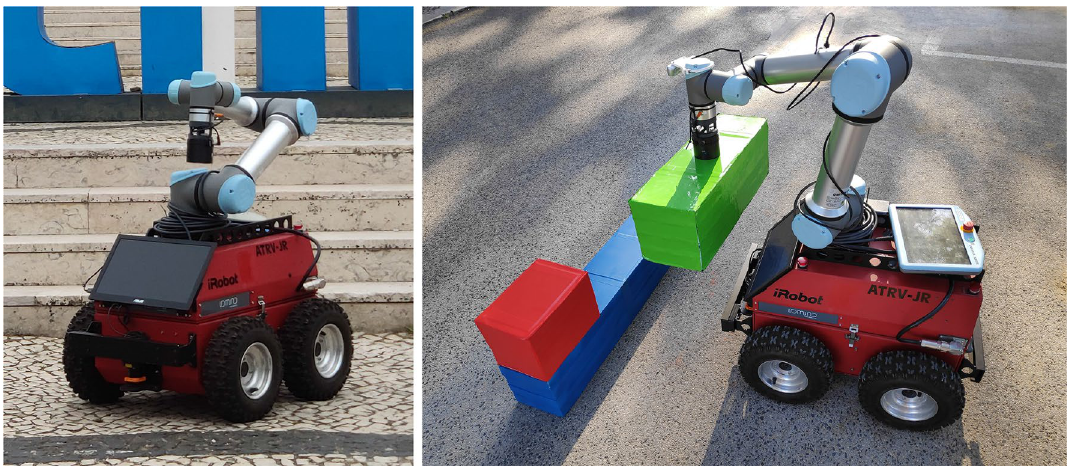
Fig. 3 The mobile manipulator developed from a refurbished ATRV-Jr mobile base and a UR5e robotic arm with a six degrees of freedom used for solving the second challenge of the MBZIRC 2020